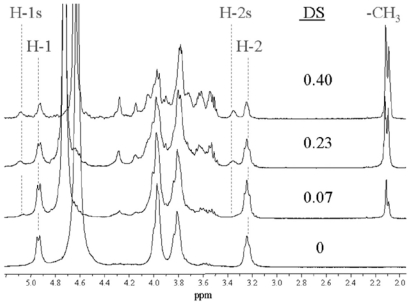
1H NMR spectra of chitosan (DP = 25, DA < 0.001) N-alkylated with the N-acetylated trimer A–A–M. Reprinted from Carbohydrate Research 337, 2002, Tømmeraas, K., Köping-Höggård, M., Vårum, K.M., Christensen B.E., Artursson, P., Smidsrød, O., Preparation and characterization of chitosans with oligosacharide branches, 2455–2462, Copyright (2010), with permission from Elsevier [303].